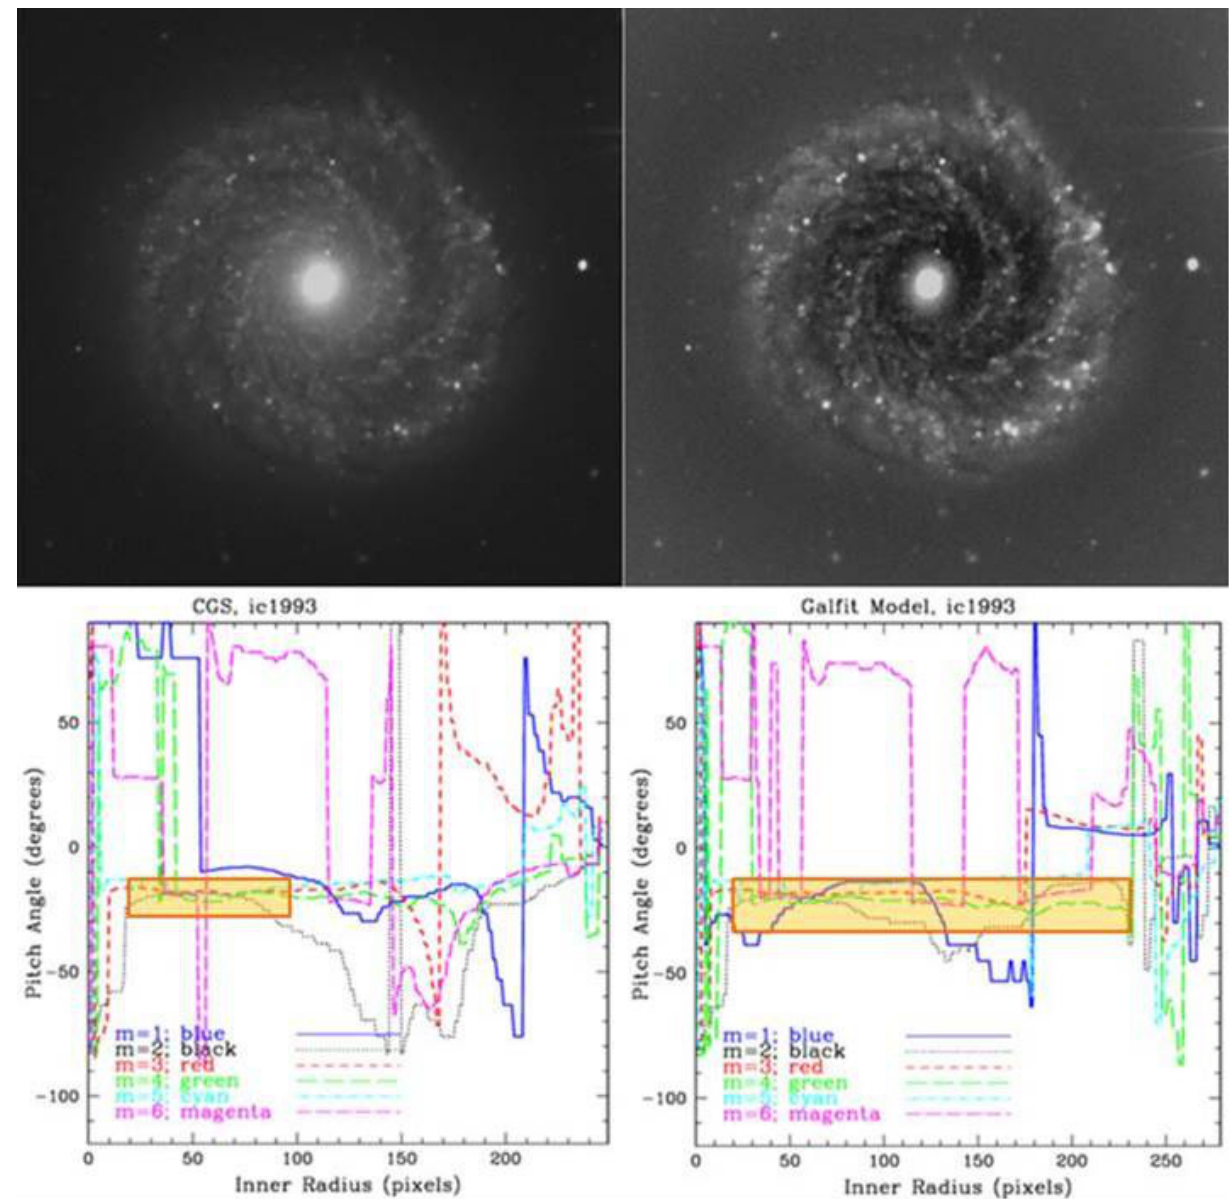
Figure 5. Improved 2 DFFT measurement of m = 2 spiral-arm pitch angle ( ) for IC 1993 by means of GALFIT [78]. ( Left Column ) Original B -band image and corresponding pitch angle measurement. ( Right Column ) Modified image using GALFIT to remove a Sérsic profile from the galaxy, amplifying the visibility of the spiral arms. 2 DFFT is capable of pitch angle measurement for both images; the user-selected stable region (highlighted orange rectangle) for the GALFIT -corrected image covers a larger range of galactic radii with a smaller standard deviation, thus producing a lower measurement uncertainty ( m = 2, φ = − 20. ◦ 46 ± 2. ◦